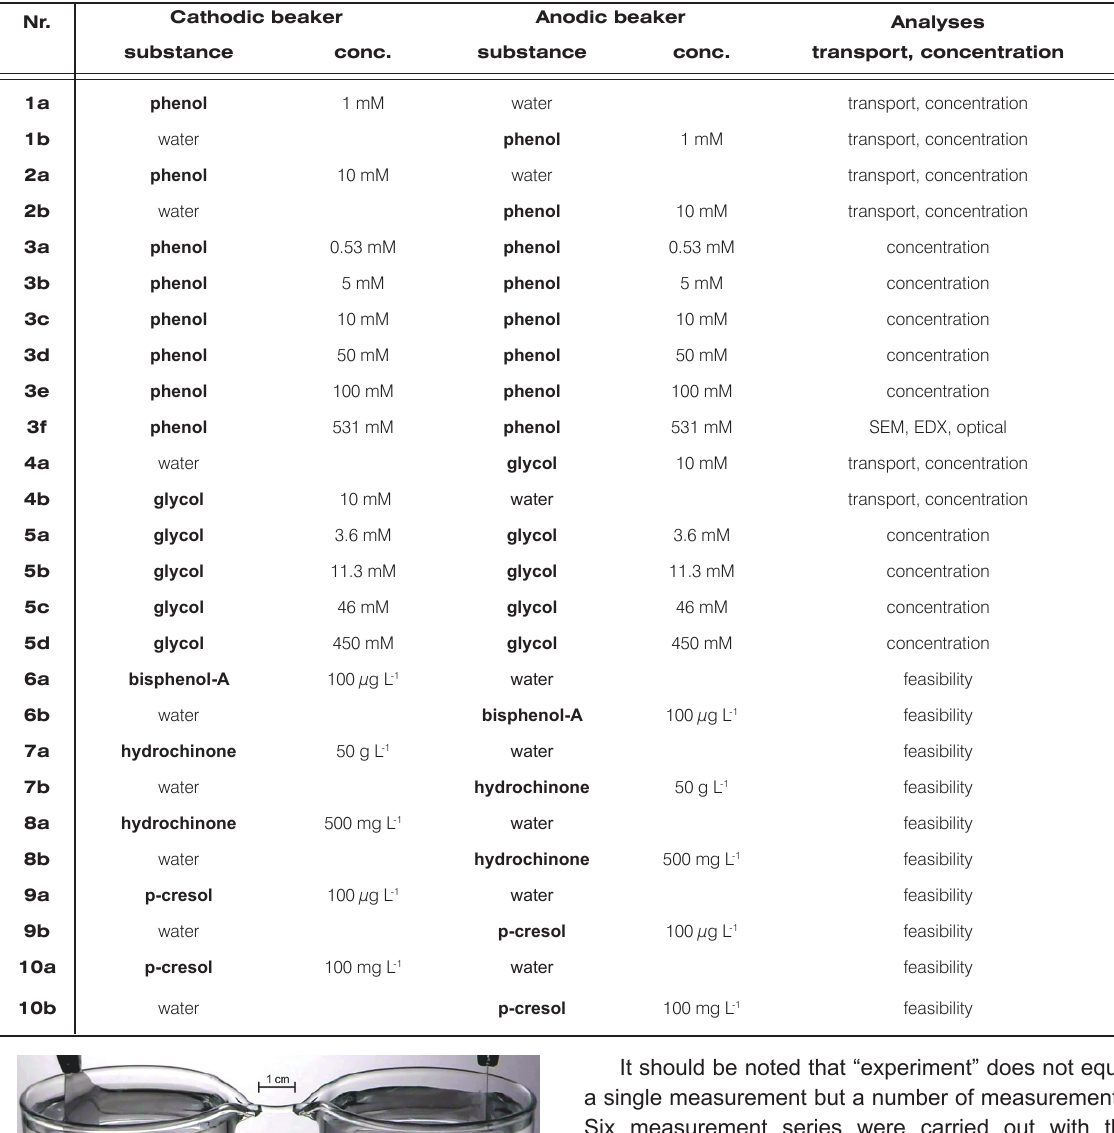
Table 1. List of conducted bridge experiments. Nr.